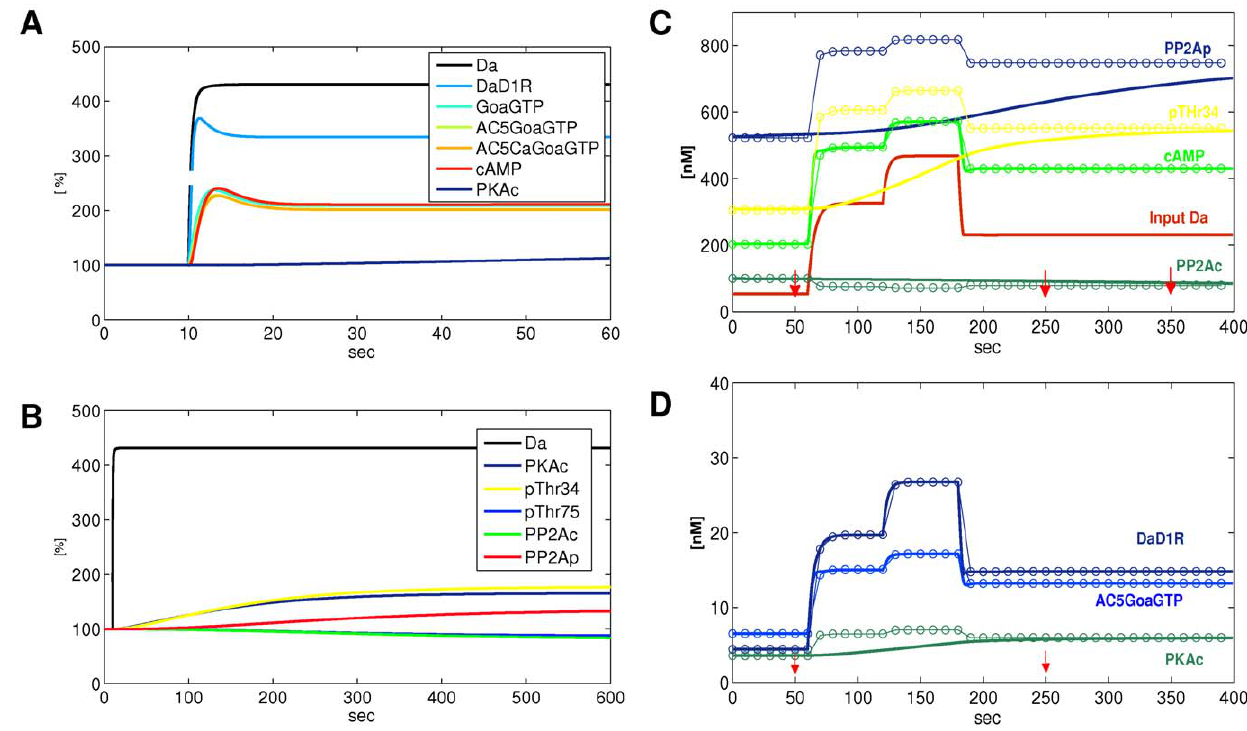
Figure 6. Dynamics of target species to Da input. A. Fast species ( v 10s) have transients. The psf approximation only calculates the steady- state value. B. For slow species no transients are apparent. It may take several minutes to reach steady state. C, D. Dots mark systemic psf values, thick lines are continuous dynamical simulations by differential equations, thin lines are interpolations between 10s psf values. Red arrows mark time points for interpolations for slow species like PP2Ac, PP2Ap, pThr34.